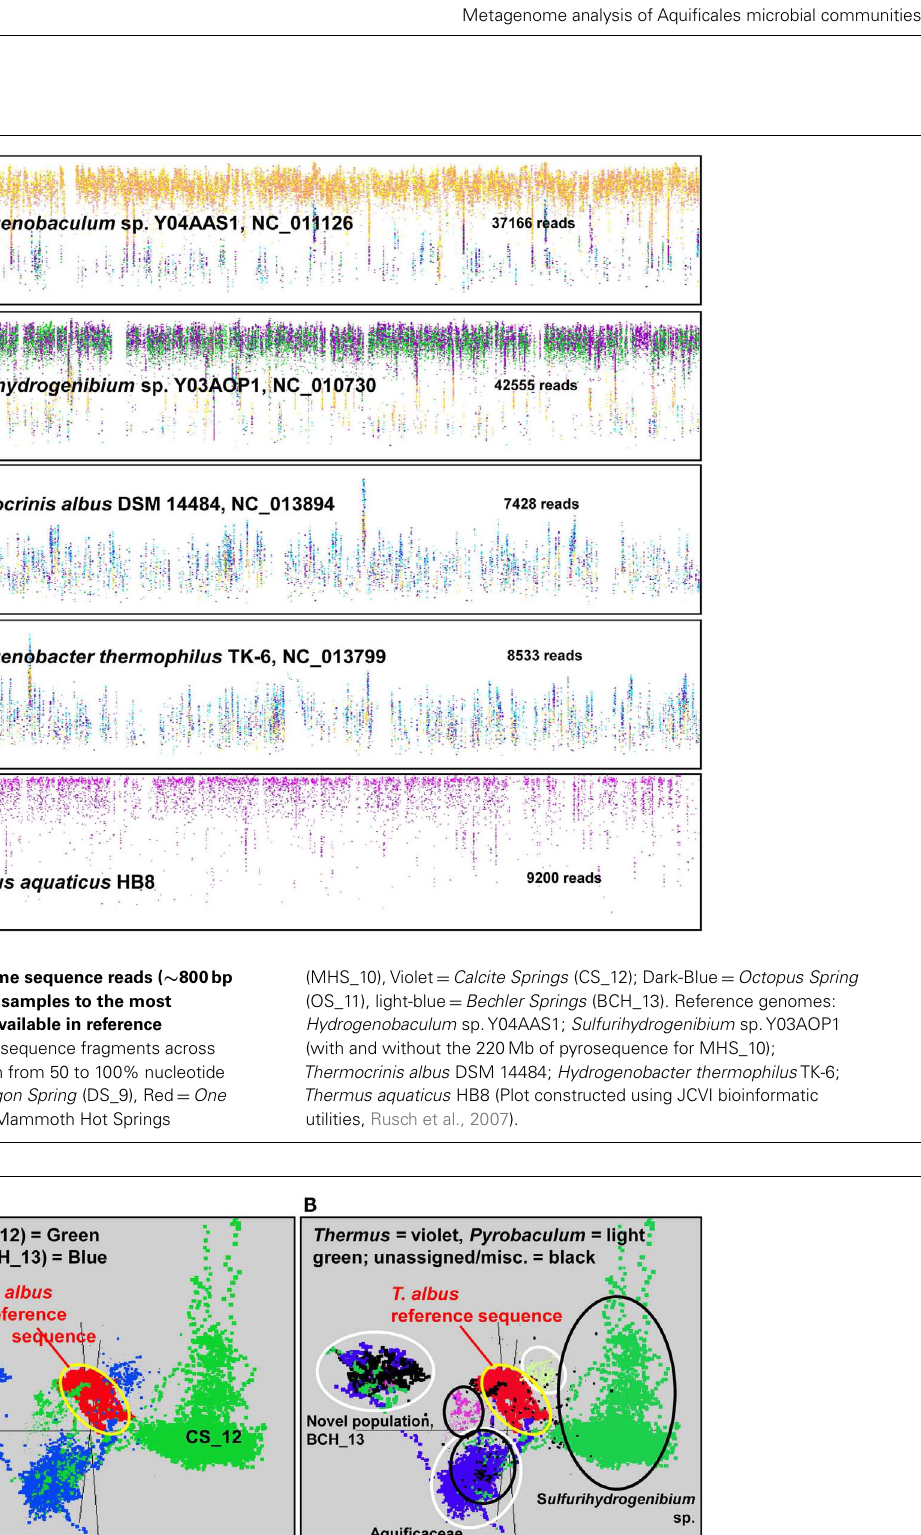
phylogenetically to reveal specific assembled sequence corresponding to particular population types within the two different sites (green = Sulfurihydrogenibium sp., blue = Aquificaceae, violet = Thermus sp.; light-green = Thermoproteaceae; unassigned = black).White circles indicate major assemblies from BCH_13, and black circles indicate major assemblies in